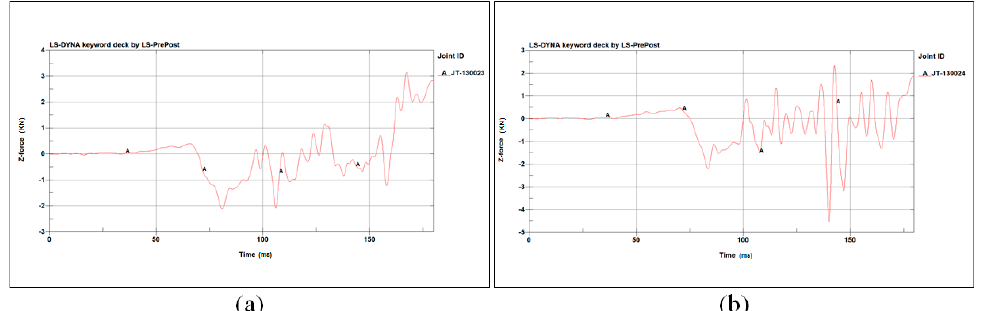
the right femur.